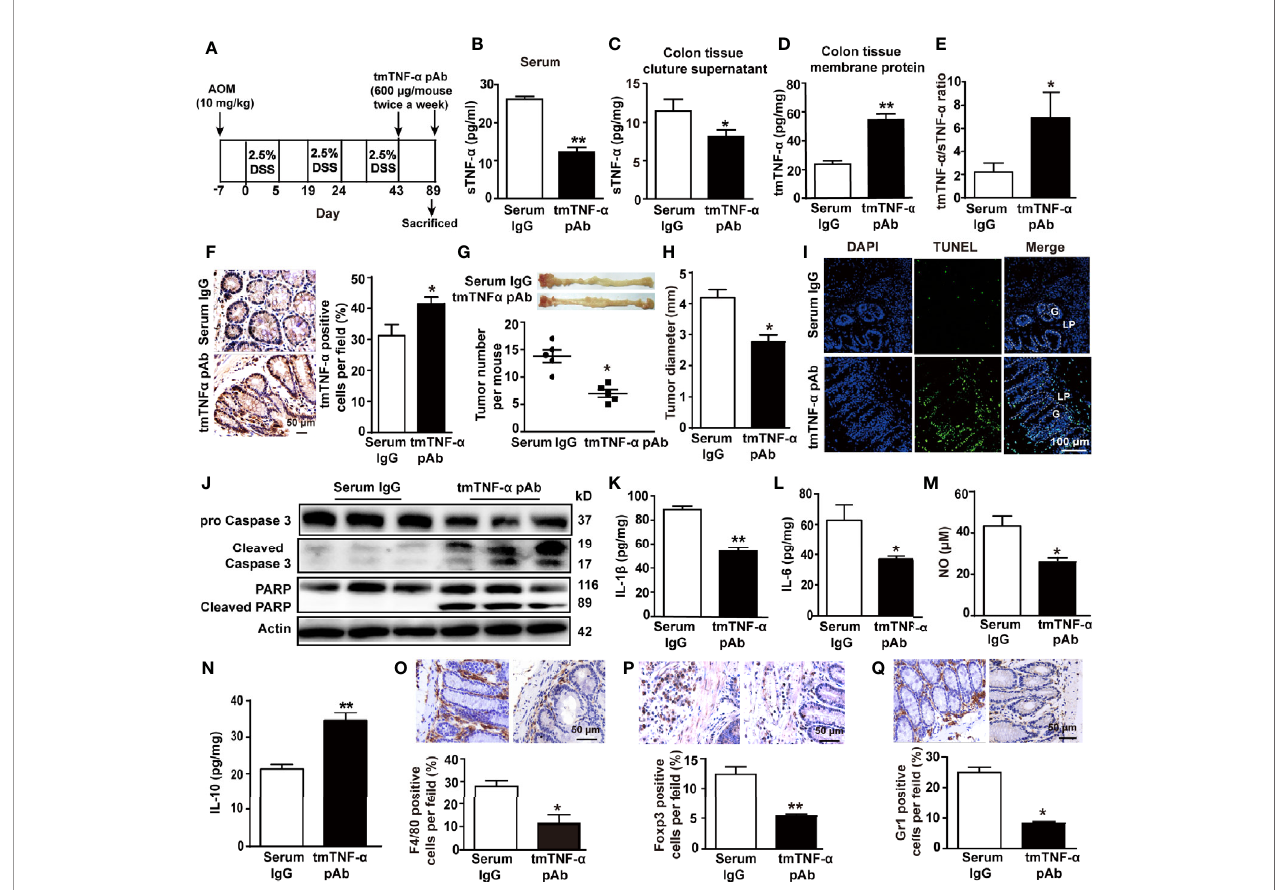
FIGURE 7 | tmTNF- a antibody treatment in the tumor stage inhibits in fl ammation and tumor growth. (A) Schematic treatment of mice with tmTNF- a pAb in AOM/ DSS-induced CAC. Mice were intraperitoneally injected with 600 m g of tmTNF- a pAb twice a week, and the treatment was from day 43 to day 89. Normal rabbit serum IgG served as a control (n = 5, each group). (B) Serum concentrations of sTNF- a detected by ELISA. Levels of sTNF- a released in supernatants (C) and tmTNF- a expression in the membrane protein (D) of 24-h-cultured colonic tissues detected by ELISA and their ratios (E). Representative immunohistochemical staining of tmTNF- a positive cells in colons (×400) and their quantitative data (F) . (G, H) tumor number and size. (I, J) Representative images of apoptosis in colonic tissues detected by TUNEL (×200), and western blot analysis for cleavage of caspase 3 and PARP. G: glands; LP: lamina propria. Concentrations of IL-1 b (K) , IL-6 (L) and IL-10 (N) in colonic tissue homogenates detected by ELISA. The levels of NO (M) in colonic tissue homogenates measured by Griess method. (O – Q) Representative immunohistochemistry images of F4/80 + Macrophages, Foxp3 + Tregs and Gr1 + MDSCs in colonic tissues (×400) and their quantitative data. All quantitative data represent the mean ± SEM. *P < 0.05, **P < 0.01 versus serum